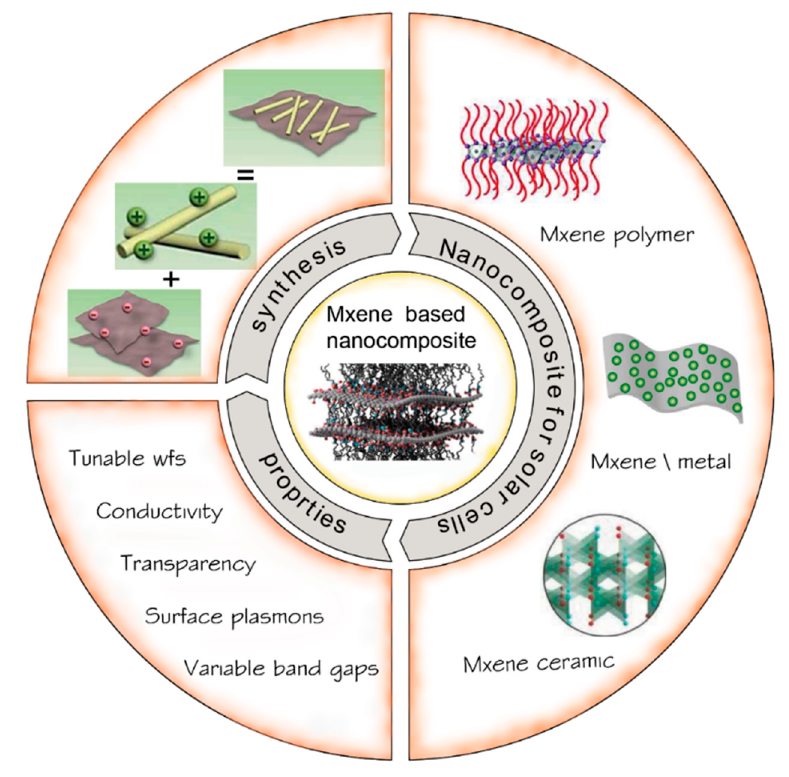
Figure 3. An illustration of a schematic overview of MXene-based nanocomposites for solar cell applications.